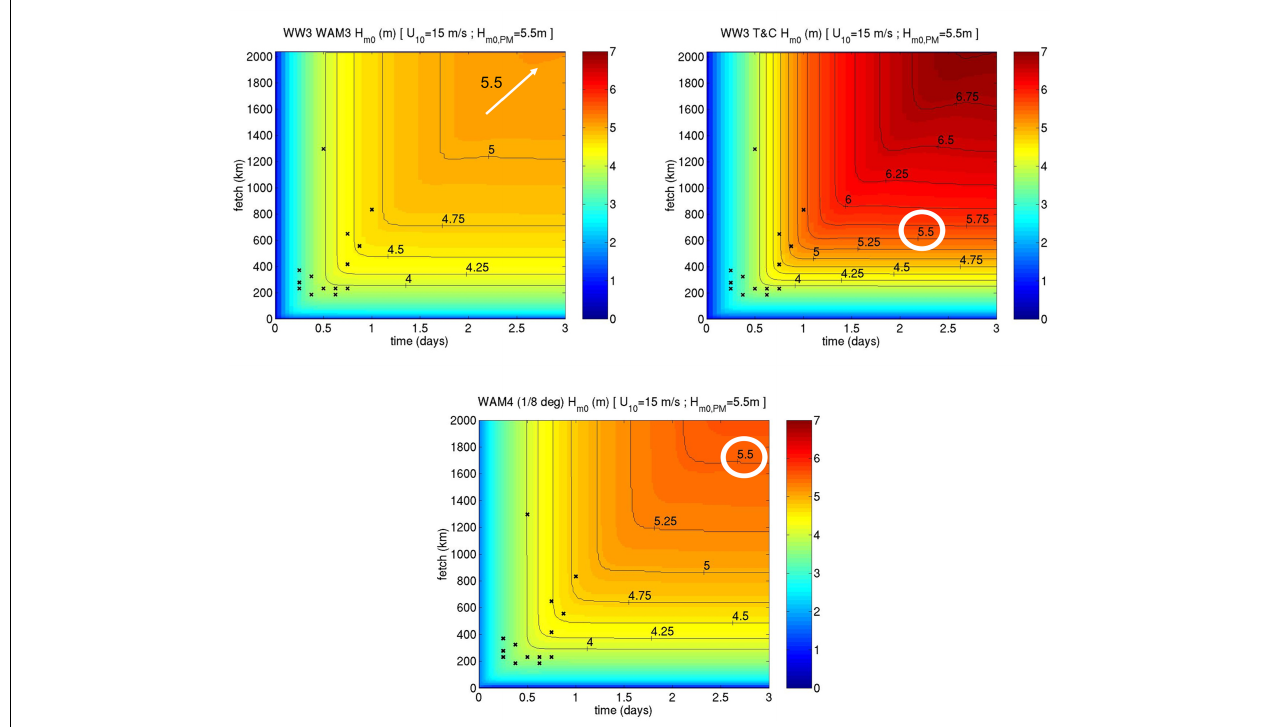
FIGURE 1 | Simulating the PM limit in WW3 (WAM3/ST1, WAM4, ST2 packages from left to right, respectively). U 10 = 15 m/s corresponds to PM H s = 5.5 m. Horizontal scale is duration of wave evolution in days, vertical scale is fetch in kilometers, and color scale is wave height in meters [Figure is reproduced from Rogers